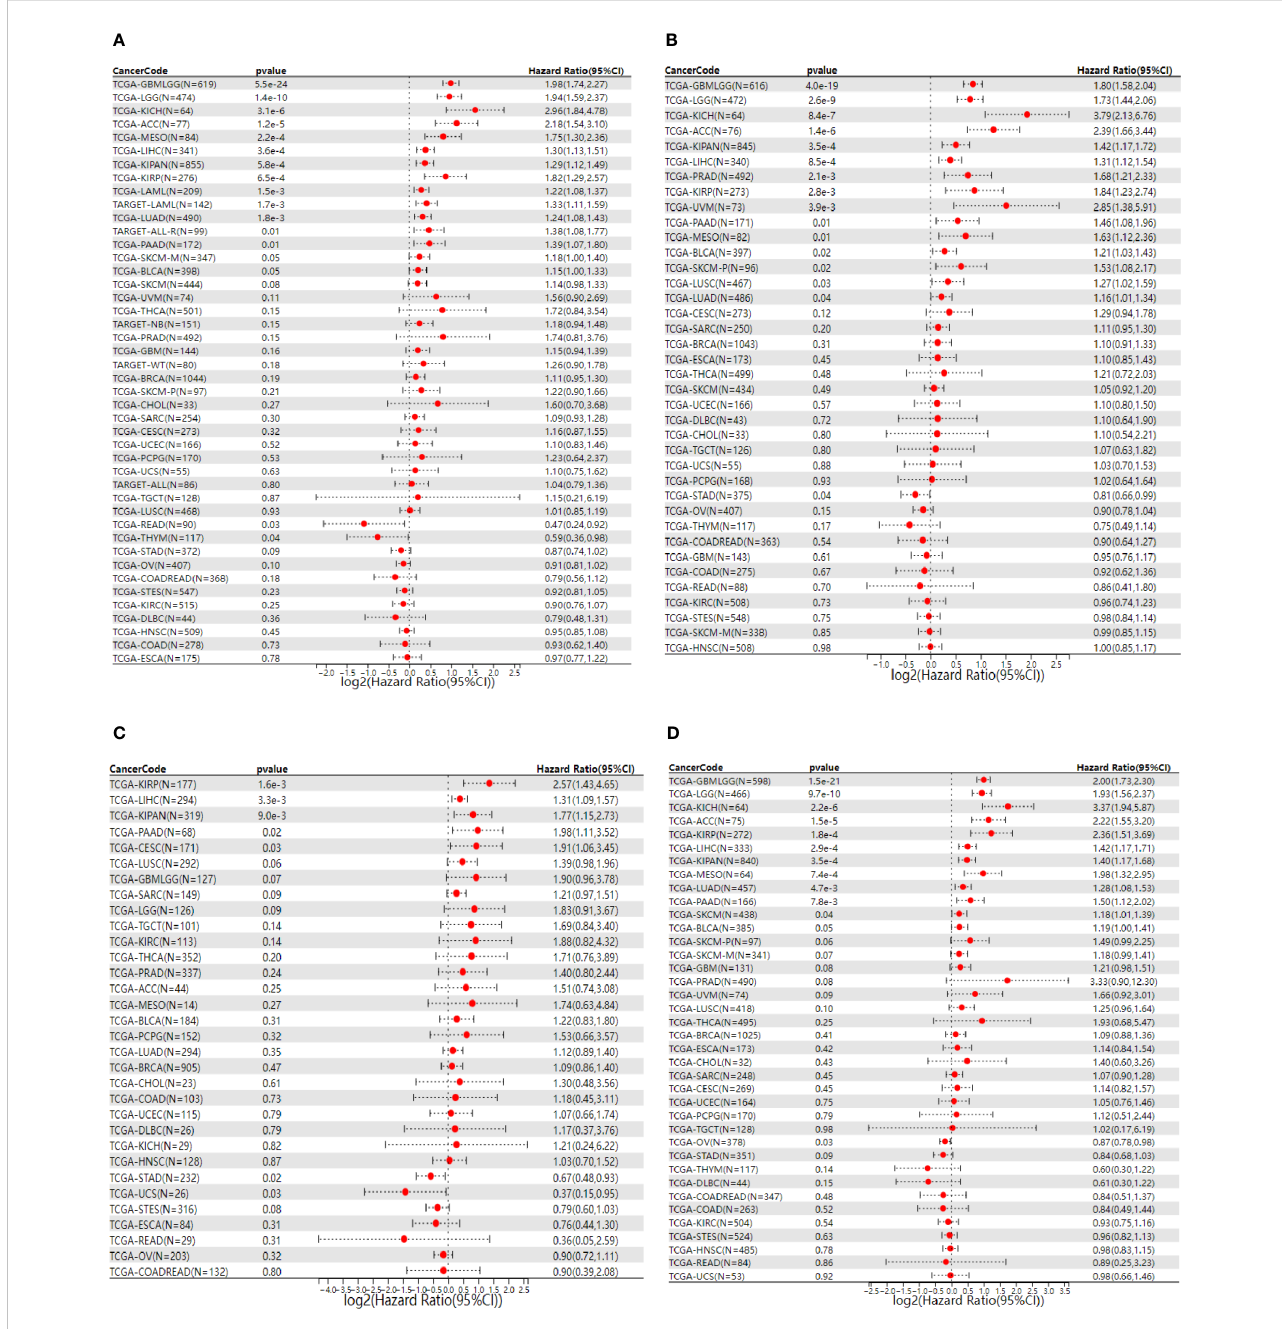
FIGURE 2 Univariate COX regression analysis of NCAPG2 with OS, PFS, DFS and DSS in pan-cancer. (A) Correlation between NCAPG2 expression and OS; (B) , DSS; (C) , DFS; (D) , PFS. OS, overall survival; DSS, disease-speci fi c survival; DFS, disease-free survival; PFS, progression-free